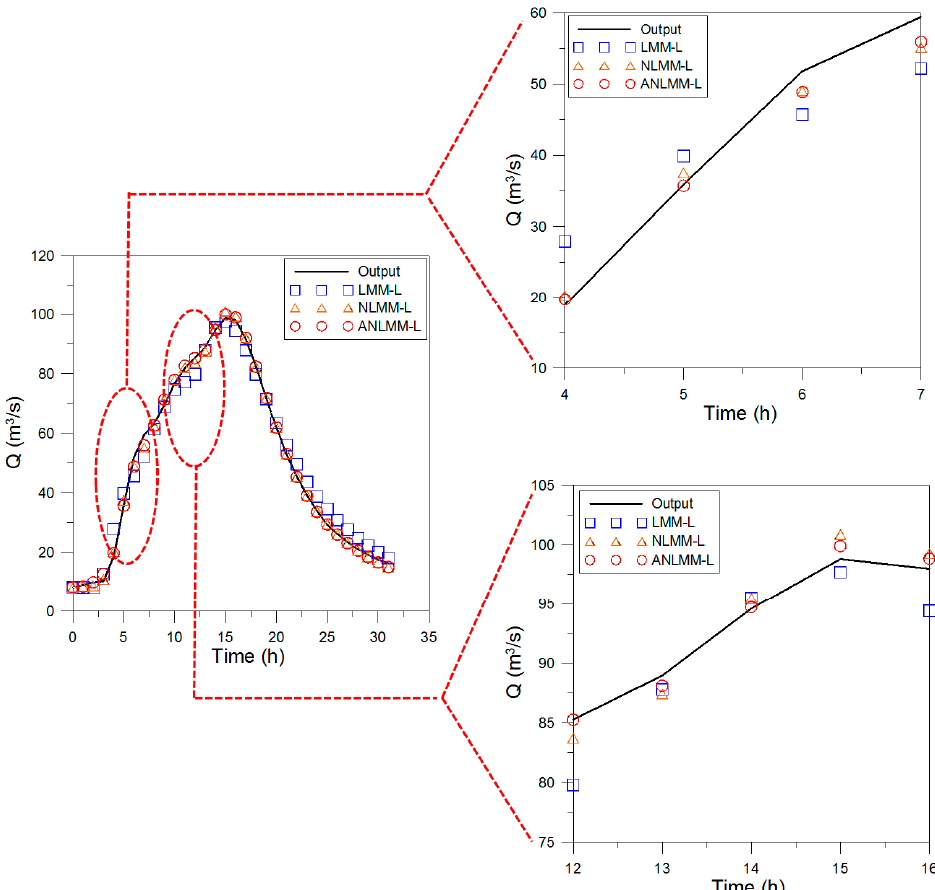
Figure 6. Comparison of results for the flood data of River Wyre October in 1982.